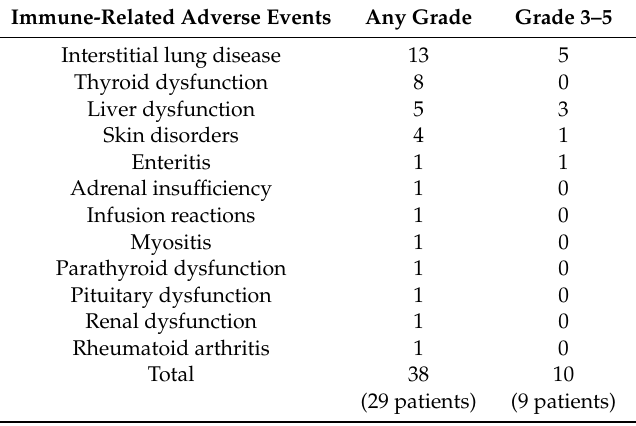
Table 3. Immune-related adverse